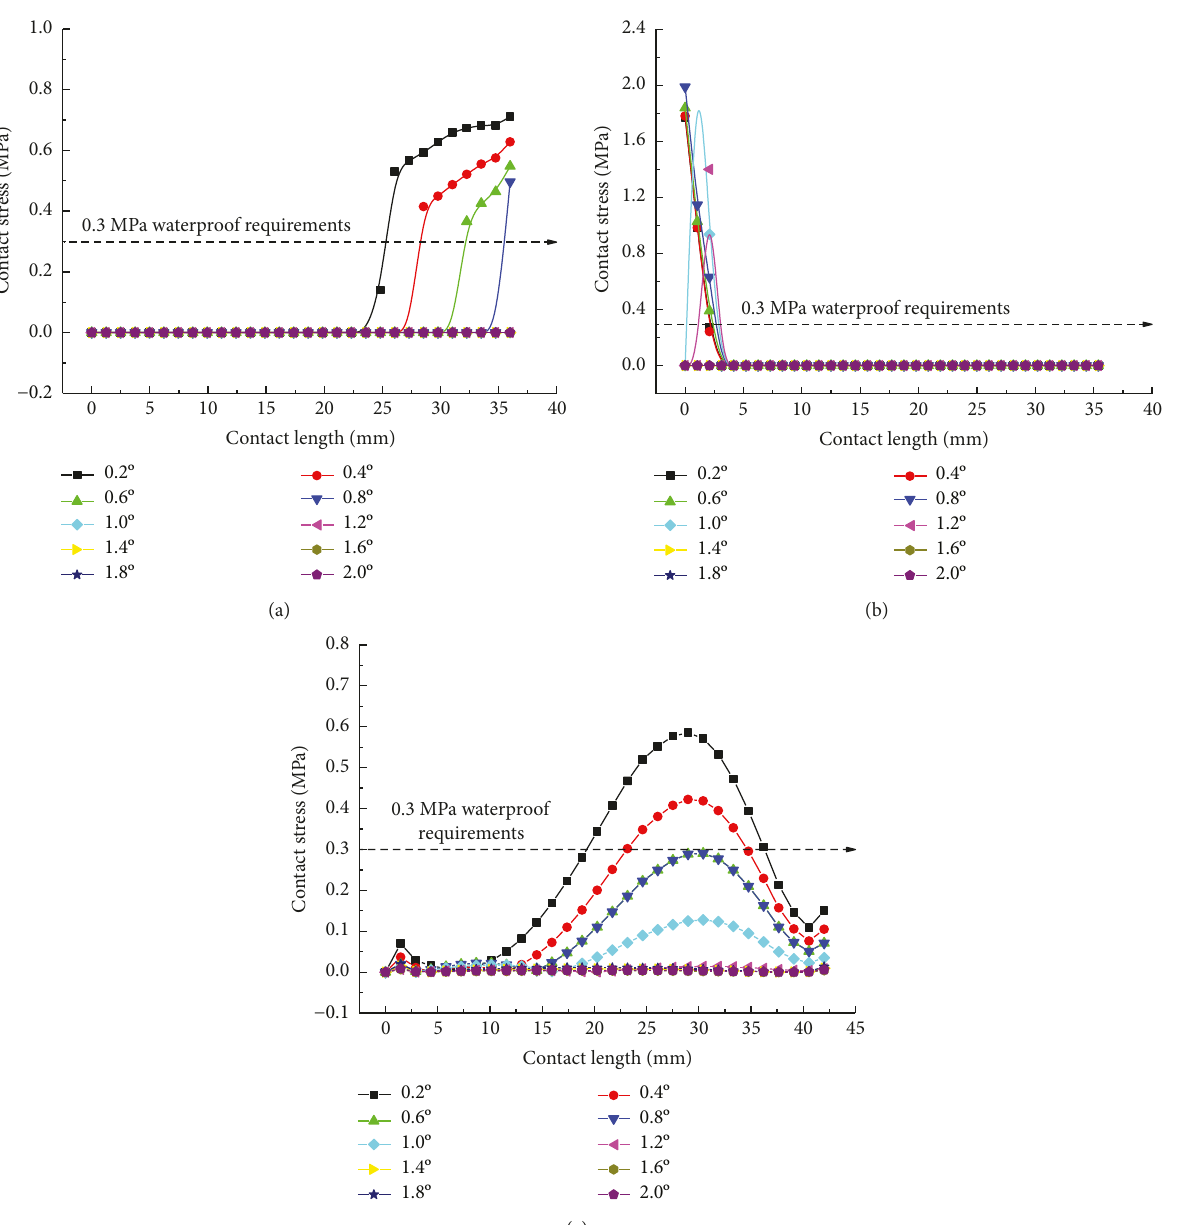
Figure 23: Contact stress curve of the second rubber ring before optimizing during anticlockwise rotation: (a) contact pressure of line 1 for the second rubber ring, (b) contact pressure of line 2 for the second rubber ring, and (c) contact pressure of line 3 for the second rubber ring.